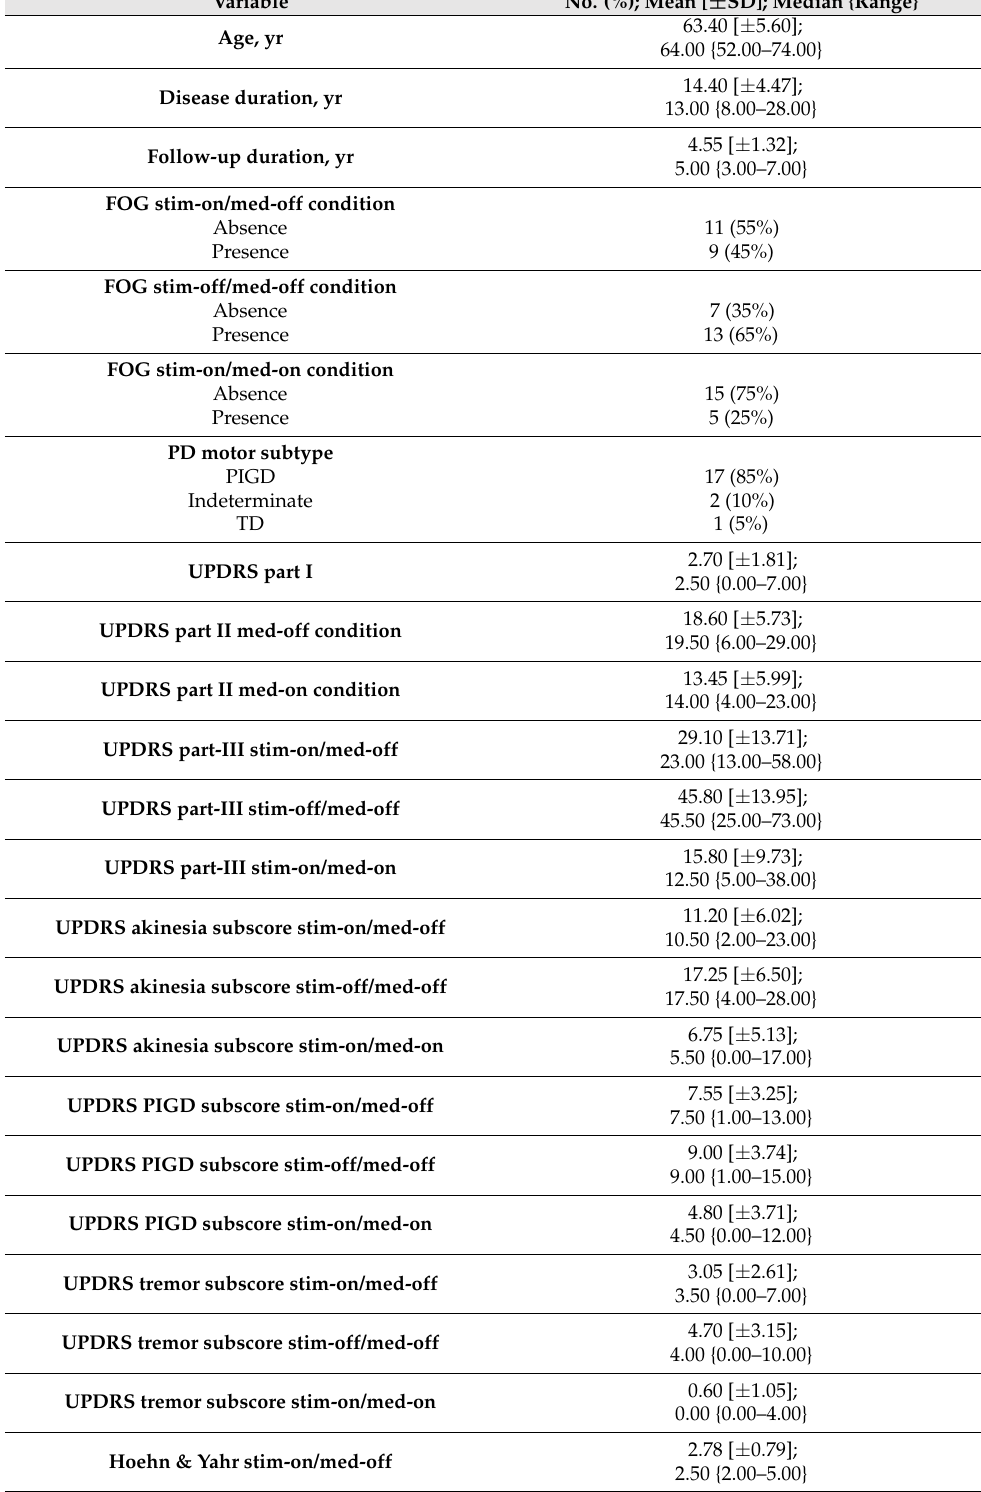
Table A2. Demographic and clinical characteristics at post-operative